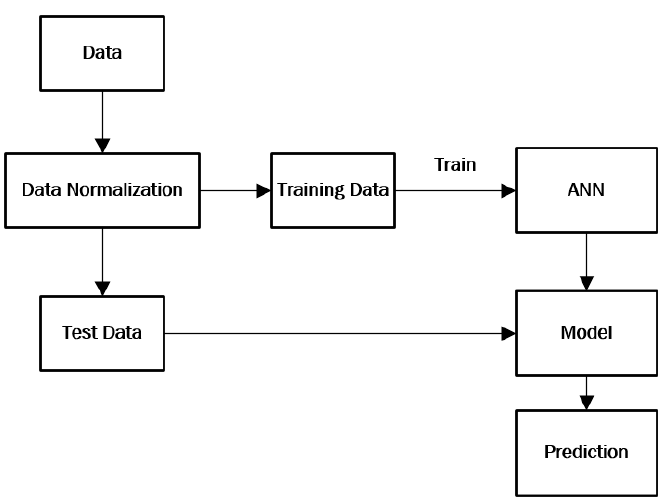
Figure 3. Training flow